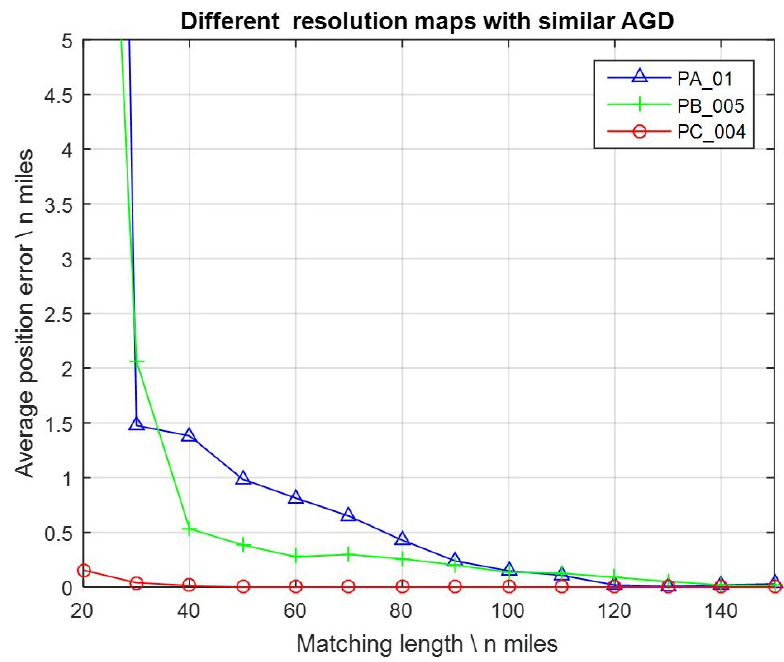
Figure 4. Average position errors with gravity maps PA_01, PB_005, and PC_004.